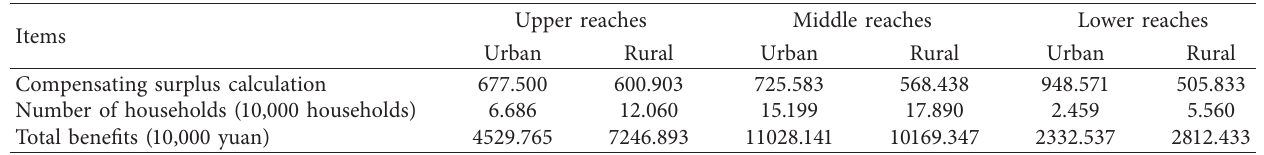
Table 6: Compensating surplus and benefits of ecological